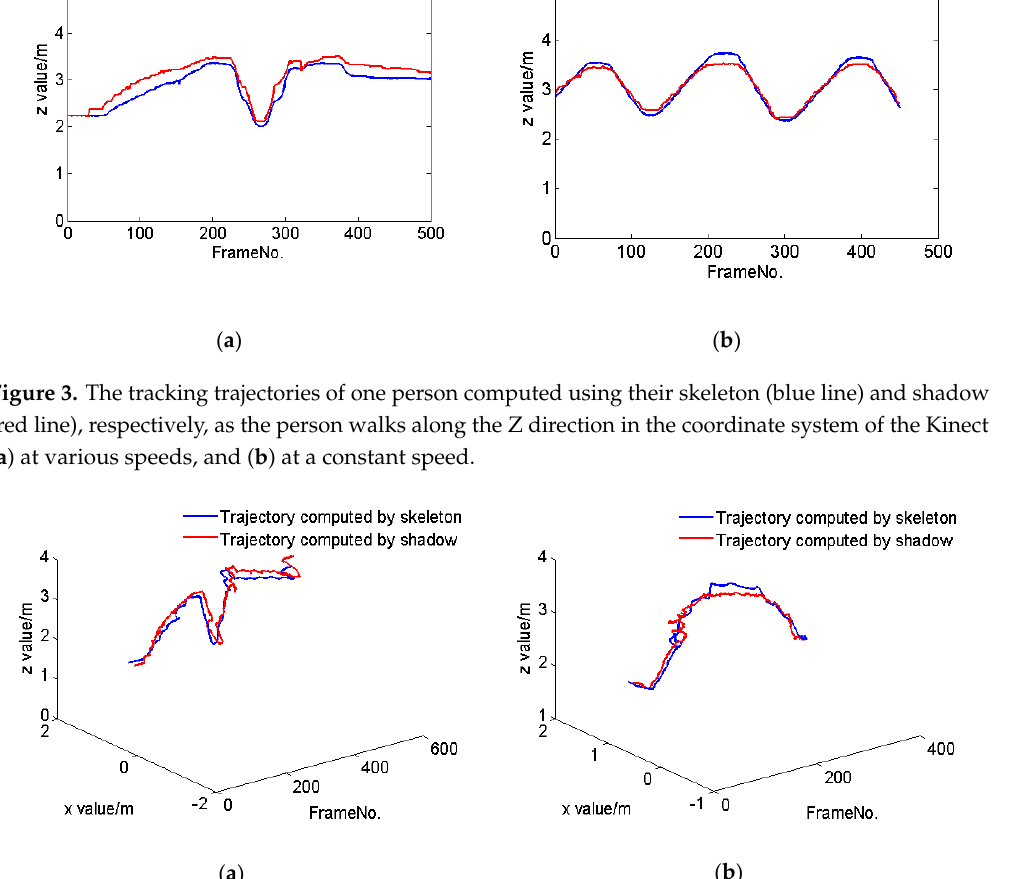
Figure 4. The tracking trajectories of one person computed using their skeleton (blue line) and shadow (red line), respectively, while they walk along arbitrary directions in the coordinate system of the Kinect ( a ) at various speeds, and ( b ) at a constant speed.